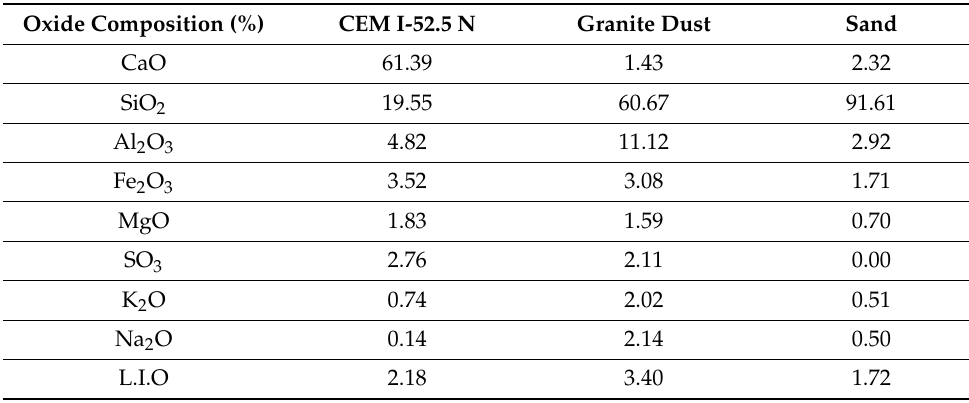
Table 2. Oxides percentage for the raw materials